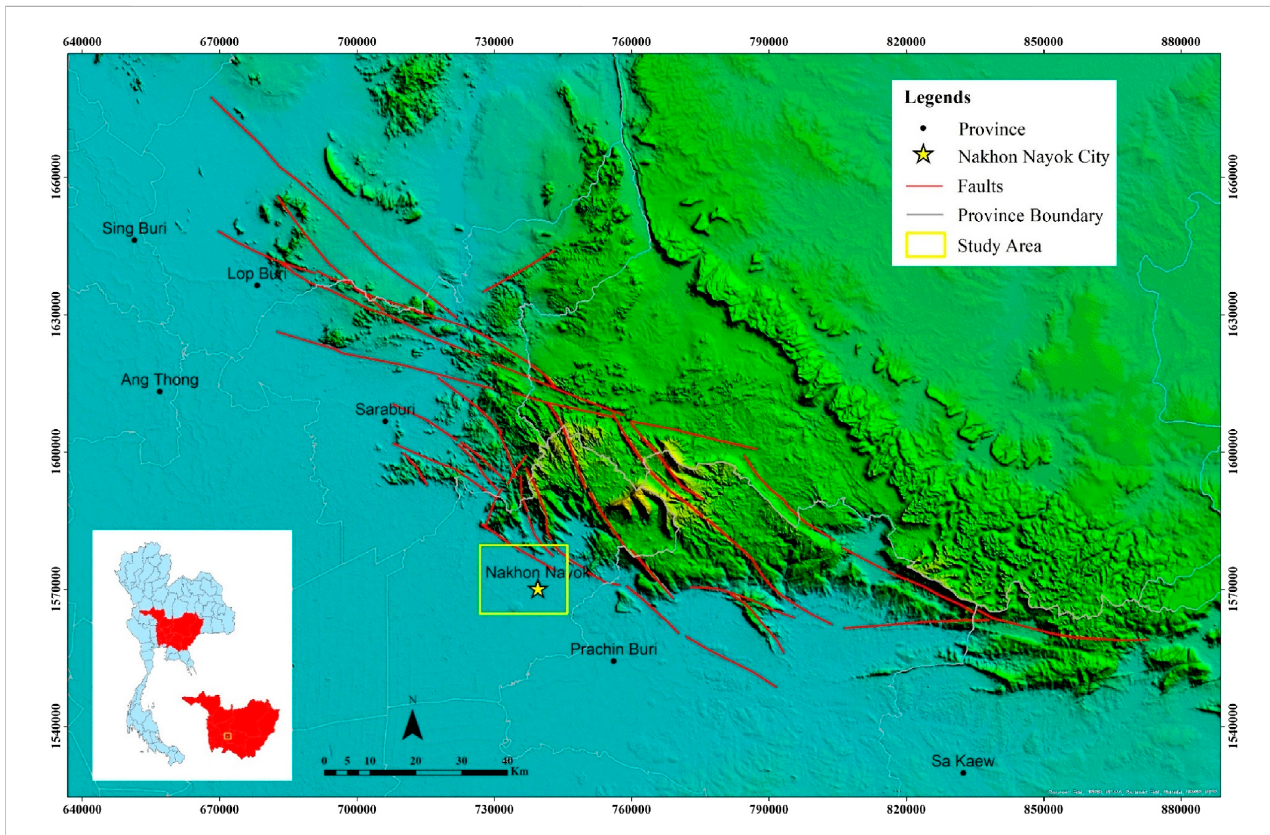
FIGURE 1 Location of Nakhon Nayok City (NNC) and the Nakhon Nayok fault zone in the northeastern part of the city.